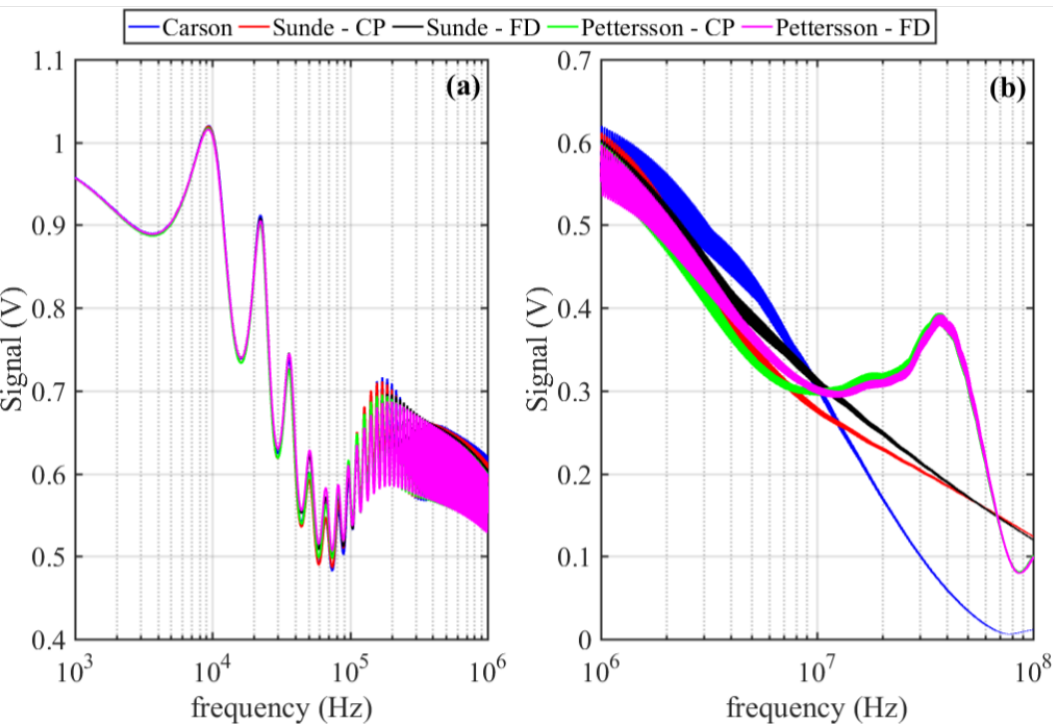
Figure 26. Injected signal at the receiving end of phase a . Signal injection in ( a ) NB and ( b ) BB. Energies 2020 , 12 , x FOR PEER REVIEW